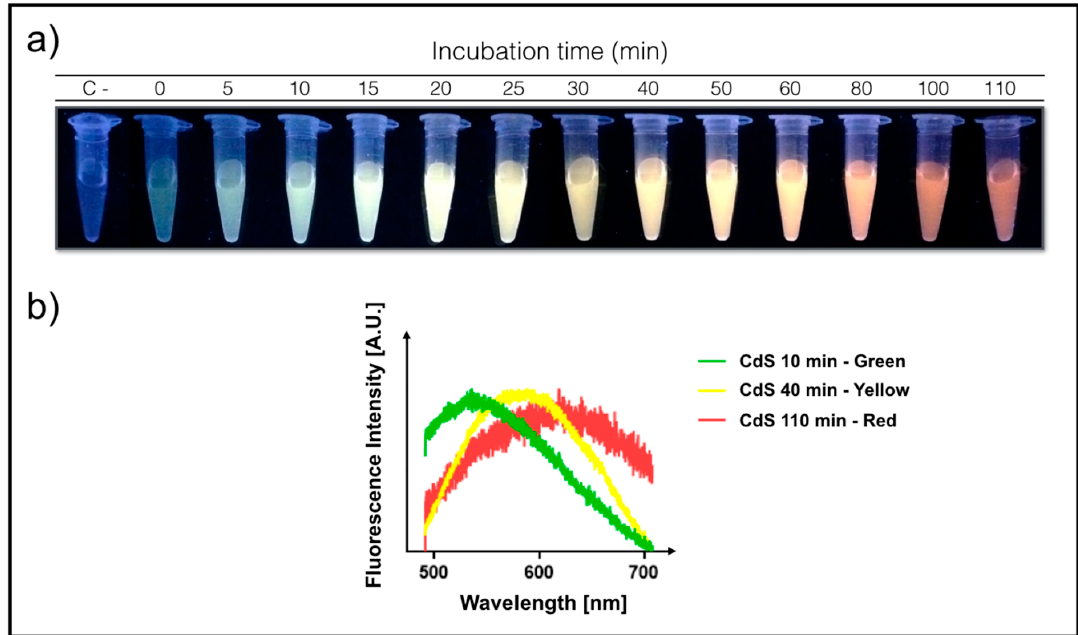
Figure 1. ( a ) Kinetics of extracellular biosynthesis of CdS Quantum Dots (QDs). Ultra Violet-exposed supernatants of bacterial cultures at different incubation times with cadmium and cysteine ( λ exc = 365 nm). ( b ) Fluorescence emission spectra of the three most representative fractions obtained during QDs biosynthesis ( λ exc = 405 nm).